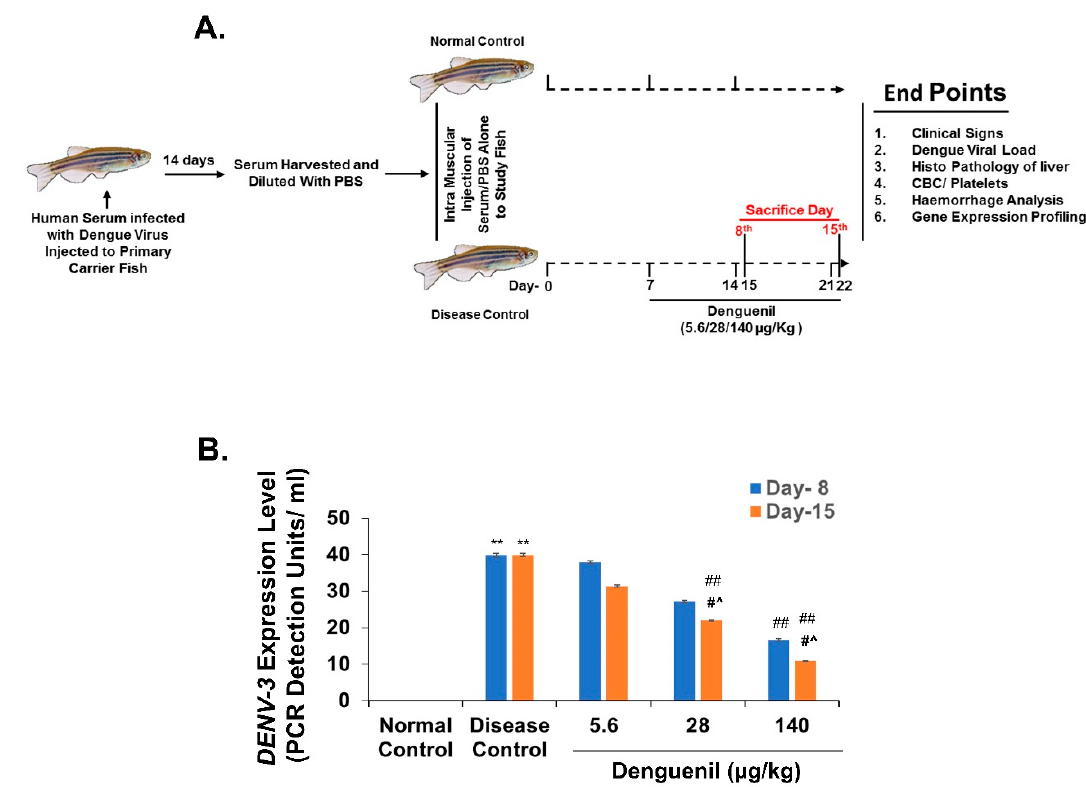
Figure 1. Denguenil inhibits dengue virus (DENV) transcript levels. ( A ) Schematic representation of zebrafish model of dengue viral pathology. Human serum infected with dengue virus was propagated in primary carrier fish. Study zebrafish (n = 24) were injected with dengue virus (DENV-3) (Disease Control) or PBS as in control (Normal Control) and treated with three different effective doses (5.6 µ g / kg, 28 µ g / kg, and 140 µ g / kg Denguenil) for various time points. ( B ) Whole RNA from liver tissue was analyzed by quantitative real-time PCR (qPCR) for the dengue viral load. Virus induced increases in the DENV-3 copy number were decreased upon Denguenil treatment. n = 24, data are presented as means ± SEM. **, ##, #ˆ p < 0.001, * Represents significant compared to Normal Control; ##, # Represents significant compared to their respective Disease Controls; #ˆ Represents significant among two time points.